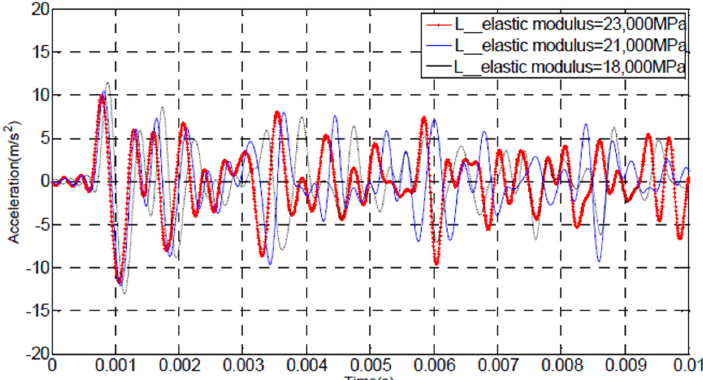
Figure 13. Effect of elastic modulus in the longitudinal direction on wave behaviour in the orthotropic material model.